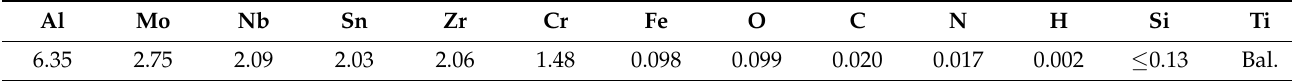
Table 1. Chemical composition of TC21 alloy, wt.%. Figure 1. Dimensions and microstructures of TC21 titanium alloy sample: ( a ) sample dimensions; ( b ) SEM image with relatively low microscope magnification; ( c ) SEM image with high microscope magnification.